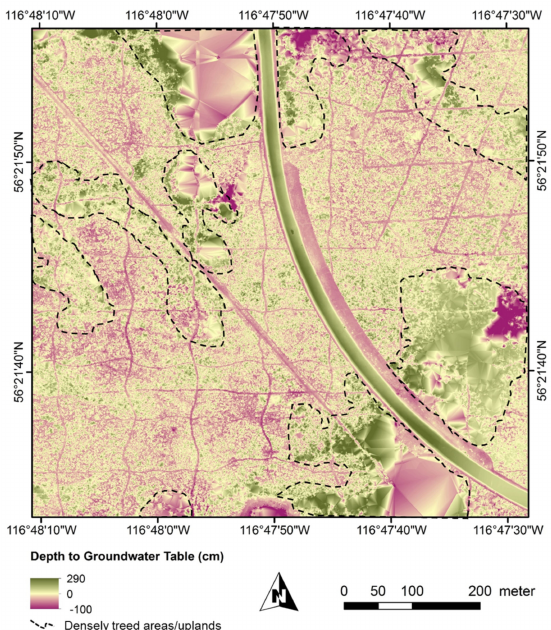
Figure 6. Predicted depth to groundwater table in the study area, where shades of green represent positive depth and shades of purple indicates negative depth (i.e.,